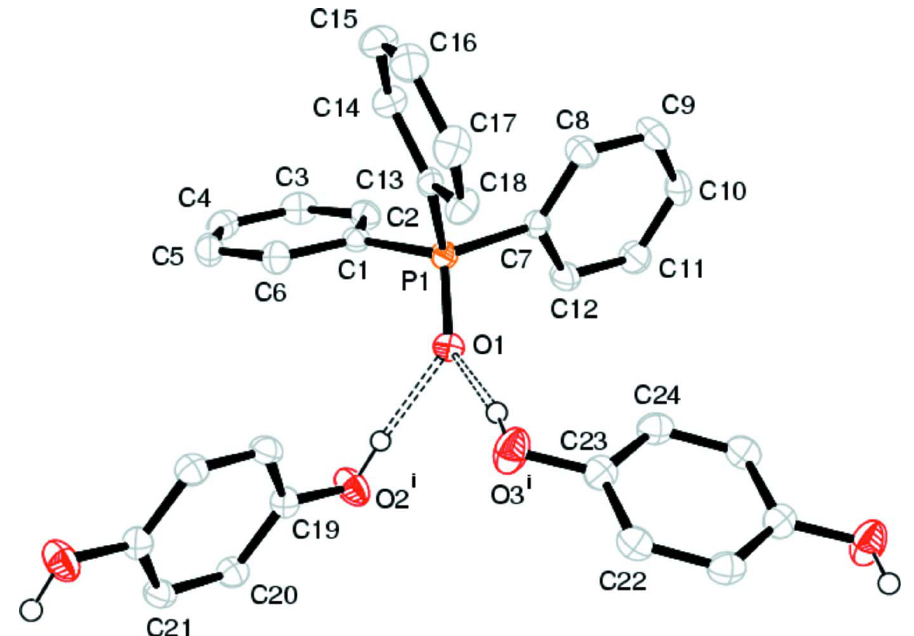
Figure 1 An ORTEP - 3 (Farrugia, 1997) plot of the title compound with the atomic labelling scheme. Displacement ellipsoids are drawn at the 50% probability level. Ring H-atoms were omitted for clarity. The dashed line indicates a hydrogen bond. [Symmetry code: (i) 1 + x , y , z